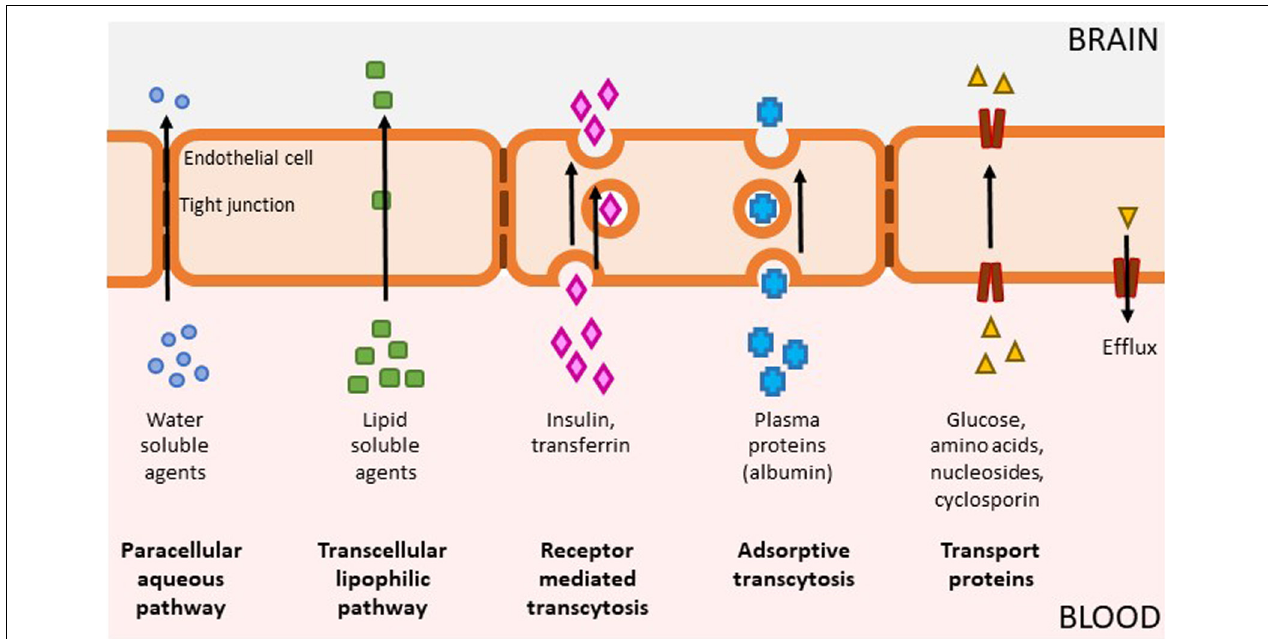
FIGURE 2 | Mechanisms of BBB penetration. The brain is separated from the rest of the body by the blood-brain barrier (BBB) which is composed of capillary endothelium containing tight junctions and specific transporter systems to exclude pathogens and toxins, which unfortunately can also include therapeutic drugs. The BBB allows the passage of some molecules by several routes (1) Passive diffusion of water soluble agents through the paracellular aqueous pathway is negligible (2) Small, lipid soluble agents (e.g., nicotine, alcohol, antidepressants) can diffuse across a concentration gradient through endothelial cells via the transcellular lipophilic pathway which represents the main entry route into the brain for many currently approved therapeutics; (3) Receptor mediated transcytosis enable delivery of proteins such as insulin, transferrin, leptin, interleukins as well as nutrients such as iron and LDL; (4) Adsorptive transcytosis modulates transport of other proteins such as albumin; (5) Specialized transport proteins such as solute carriers can transport a range of substrates including glucose, amino acids, and drugs such as cyclosporine and azidothymidine. This category also includes efflux transporters, which is a key element of the BBB that can actively transport a variety of lipophilic drugs out of the endothelial cells. Brain penetration leading to exposure at the site of action, binding to the pharmacological target and expression of pharmacological activity are required for compound efficacy. Many drugs, including kinase inhibitors, have not been optimized for BBB penetration and as a result, they have reduced partitioning to the CNS. In order to achieve sufficient levels of exposure for compounds with suboptimal levels of CNS penetration, this means the level of systemic exposure will be significantly higher, which can lead to undesirable on- and off- target